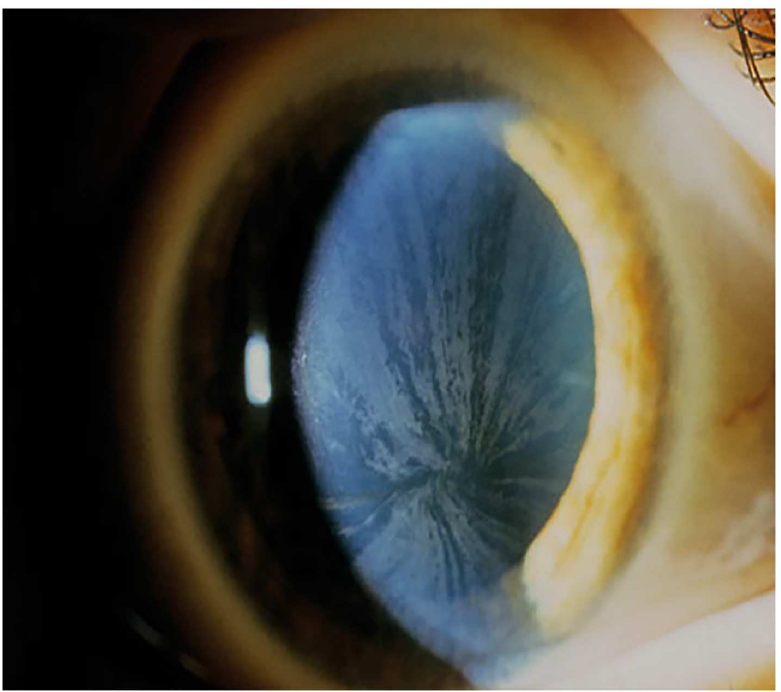
Fig 3. Cornea verticillata grade 3 in patient suffering from Morbus Fabry. A bilateral,whorl-like pattern of powdery,white, yellow or brown